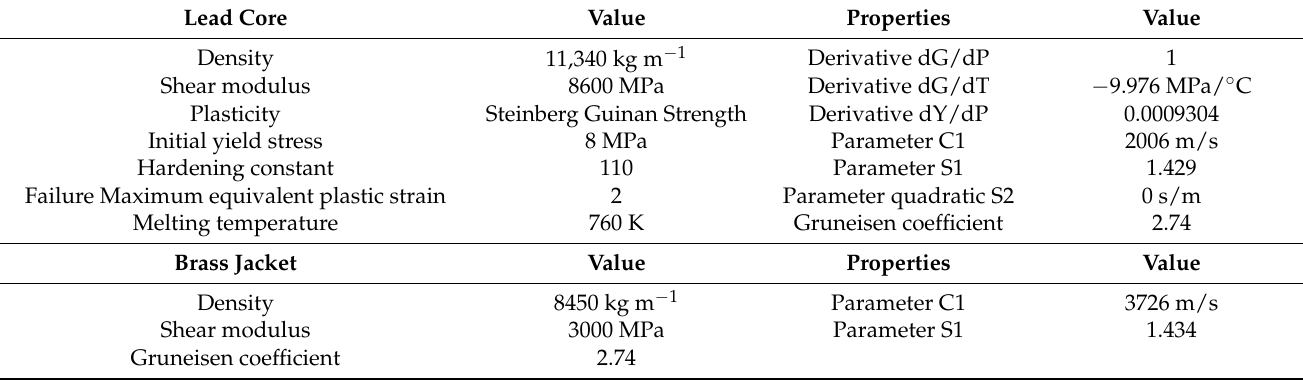
Table 1. Summary of key properties for the material used in the 7.62 × 51 mm 2